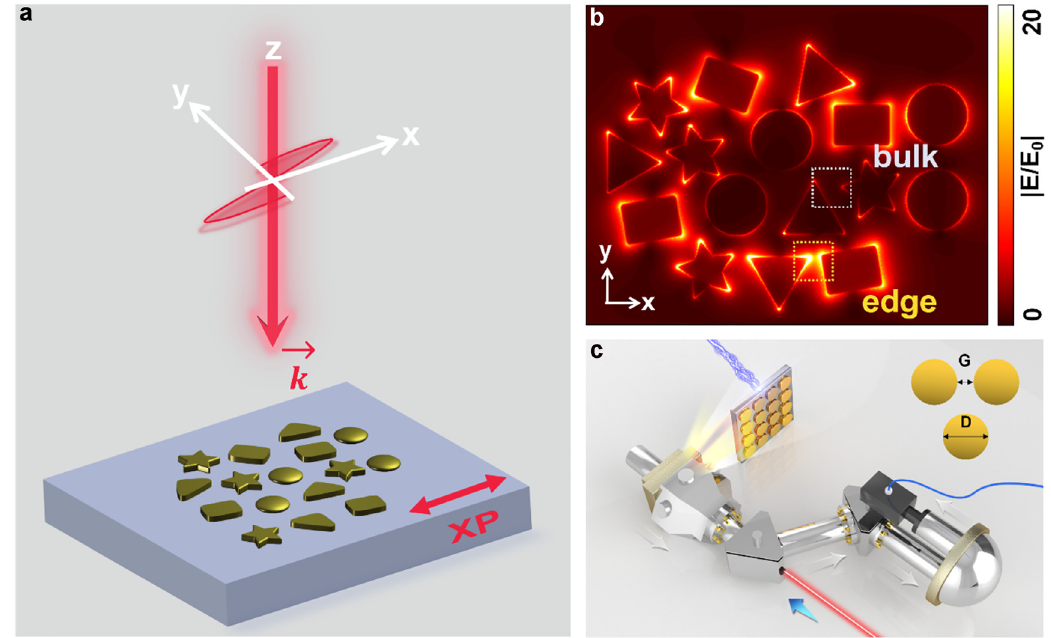
Figure 1: Schematic illustration of random plasmonic meta-array and the experimental setup. (a) Picture of a random array of plasmonic particles with different shapes and gaps between each of particles. The direction of the red arrow, along the z -axis, indicates the propagation direction of linear polarized incident plane-wave. The two-way red arrow indicates the direction of XP light. (b) Simulated electric field distribution under XP excitation (by FDTD method). The yellow dashed rectangle represents part of the area of edge and the grey dashed rectangle represents part of the interior. The simulated suppression ratio is 27.7. (c) Schematics of the experimental instruments of PEEM. The blue arrow indicates the direction of the incident laser and the grey arrows indicate the direction of collected electrons escaping from the sample surface. The sample composed of gold disks is fabricated by EBL on the ITO substrate. The gaps G between the nearest disks are 20 nm, and the diameter of each disk is fixed 120 nm in our